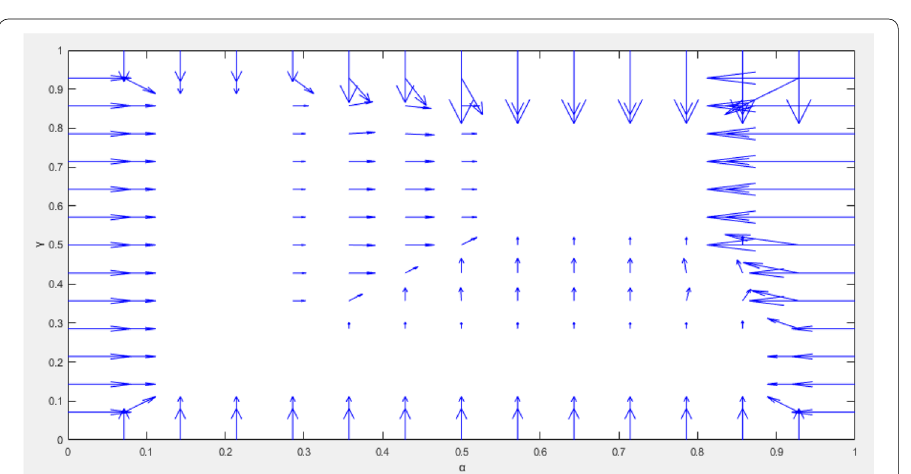
Fig. 7 Model dependency α and γ on the security